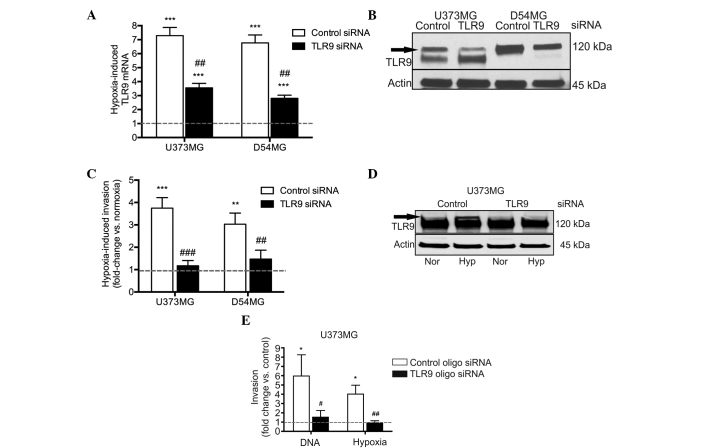
Hypoxia-induced TLR9 (A) mRNA and (B) protein expression as indicated by the arrow in the U373MG and D54MG cells. Actin bands were used to indicate equal loading. (C) Hypoxia-induced invasion in the indicated cells. Data are presented as a fold-increase of invasion in hypoxia, as compared with invasion in normoxia (indicated by the dotted line; mean ±SEM; n=7–12) **P<0.01 and ***P< 0.001, vs. normoxia; and ##P<0.01 and ###P<0.001, vs. the corresponding control siRNA cells. (D) Expression of TLR9 protein (indicated by the arrow) in normoxia and hypoxia in U373MG cells transiently transfected with control or TLR9 oligo siRNA molecules. The blot was stripped and reblotted with anti-actin antibodies to demonstrate equal loading. (E) G-quadruplex-DNA (DNA) and hypoxia-induced invasion of the U373MG cells demonstrated differences in the invasive responses between control and TLR9 siRNA cells. Data are presented as a fold-change in invasion as compared with the corresponding control (as indicated by the dotted line, corresponding to vehicle treatment for G-quadruplex-DNA-induced invasion, and invasion in normoxia for the hypoxia-induced invasion) (mean ± SEM; n=7–9). *P<0.01, vs. the corresponding control condition; and #P<0.05 and ##P<0.01, vs. the control siRNA cells. TLR9, toll-like recptor-9; Nor, normoxia; Hyp, hypoxia.